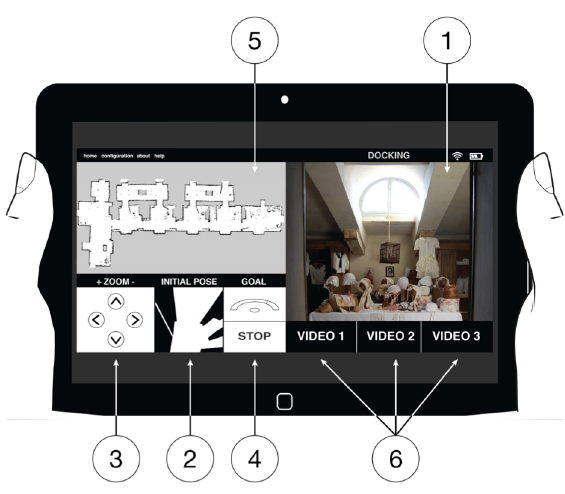
Figure 6 | Draft of the Graphical User